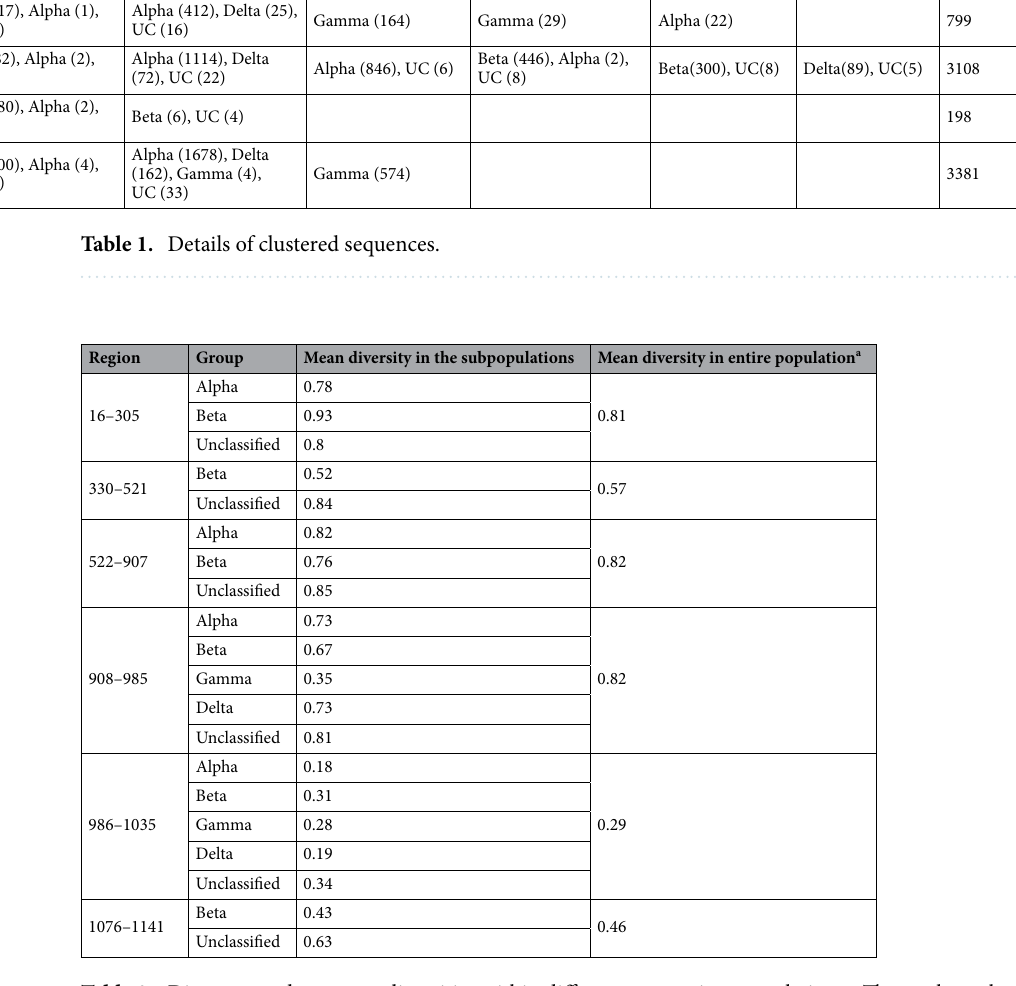
Table 2. Distances and sequence diversities within different coronavirus populations. a The total number of analyzed sequences is mentioned in Table